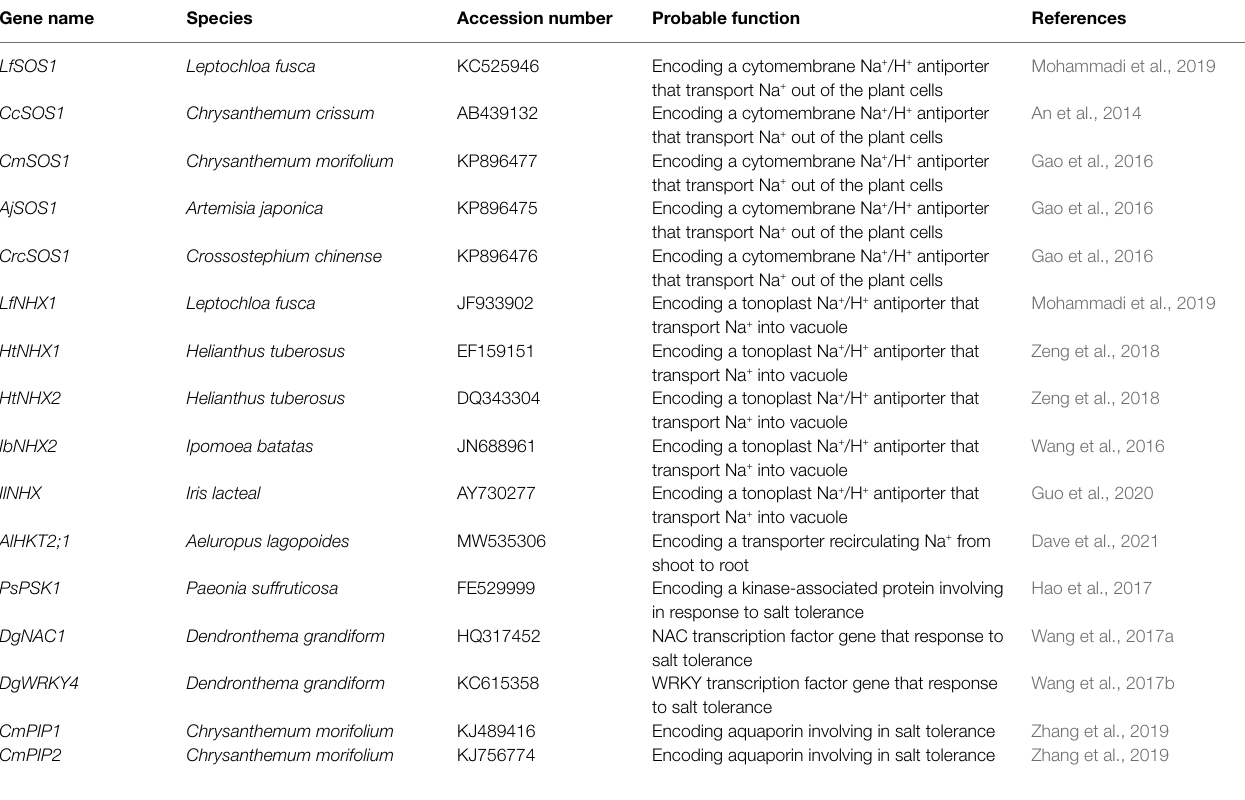
TABLE 2 | Genes involved in salt tolerance of salt-tolerant ornamental flowering